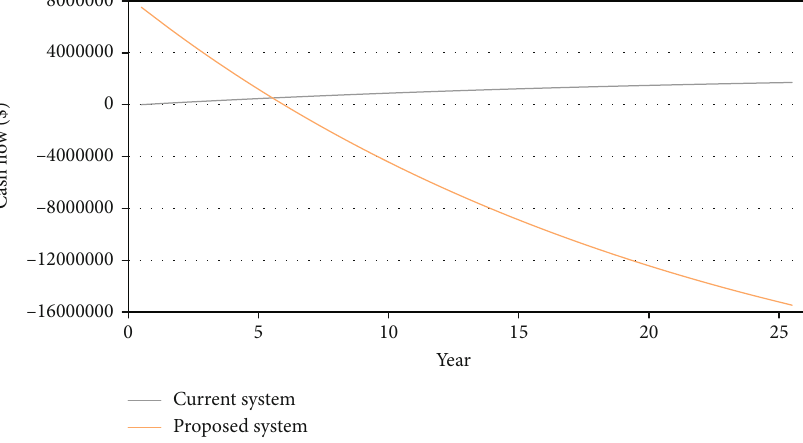
Figure 13: Cumulative cash fl ow over the project lifetime.